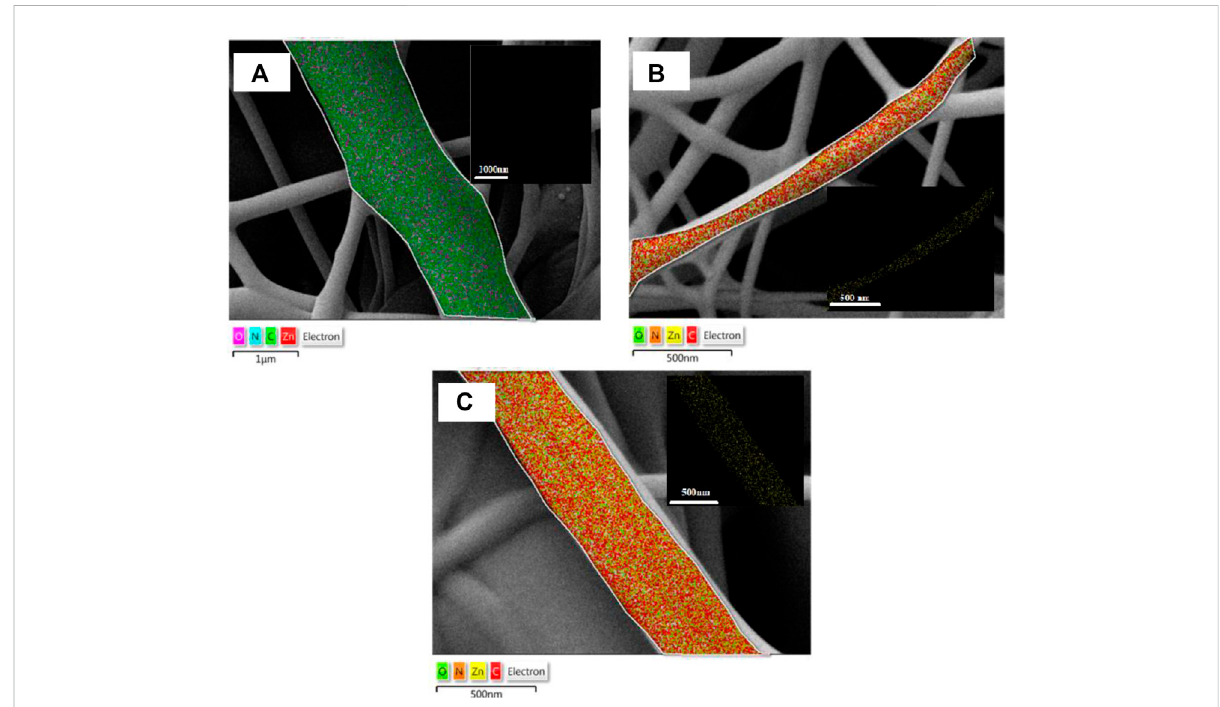
FIGURE 3 Elemental map of (A) PCL15CS3, (B) PCL15CS3ZnO1Cur1, and (C) PCL15CS3ZnO1Cur3.